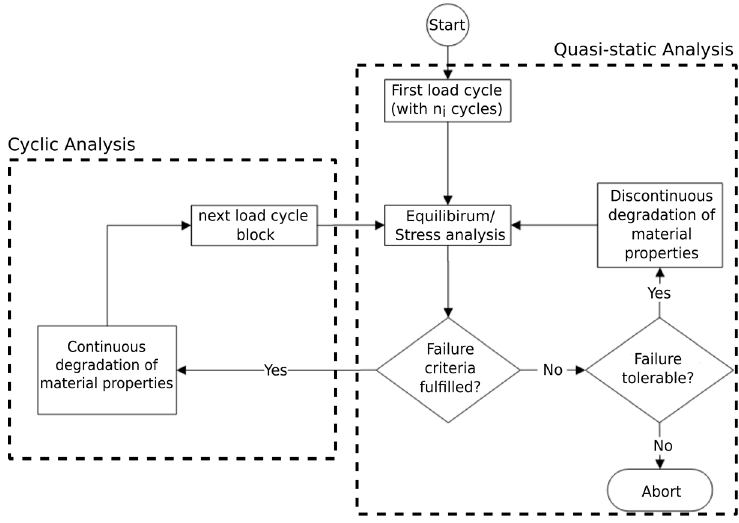
Figure 14. Flowchart of the fatigue damage model (FDM) with discontinuous and continuous method of degradation [11].